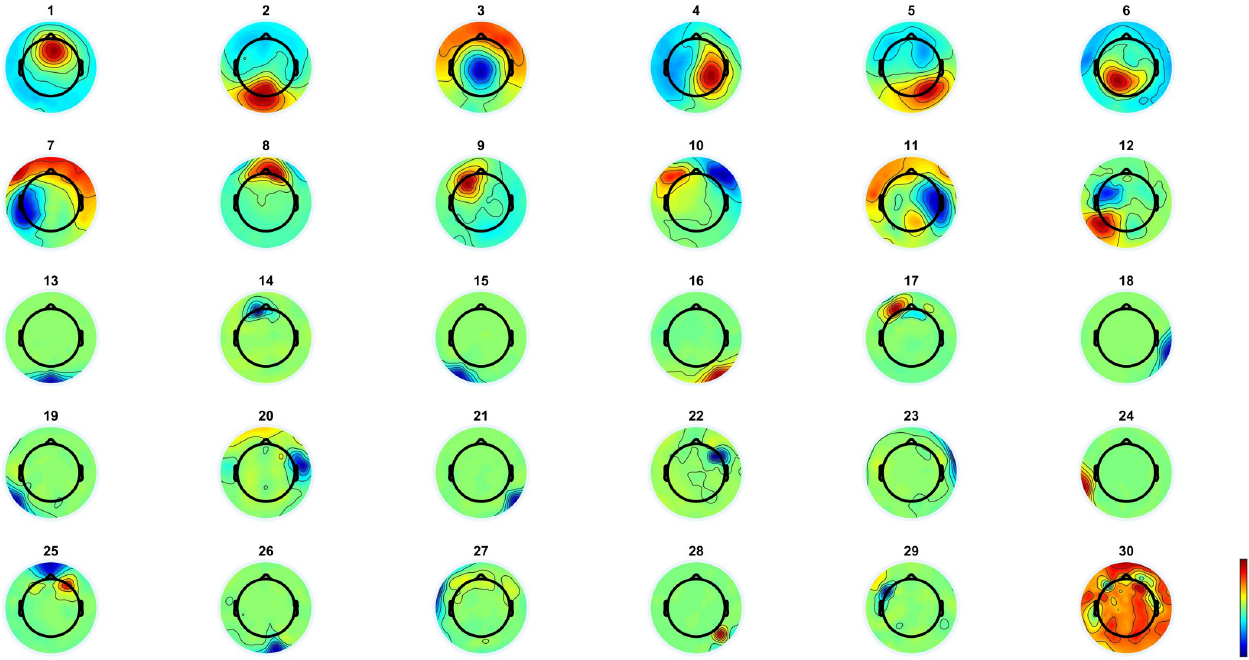
Fig 2. The group-level ICA estimated spatial filters. Components 1, 2, 3, 4, 5, 6, 7, 9, 11 and 12 were retained in the data because they were judged to have a dipolar field structure and thus were likely be generated by brain tissue. Components 8 and 10 were pruned out of the data since they were judged to be likely to have been caused by eye movements. Components 13, 14, 15, 16, 17, 18, 19, 20, 21, 22, 23, 24, 25, 26, 27, 28, 29 and 30 were pruned out of the data because they were judged to be random pop-out artefacts and mechanical artefacts mostly constrained to few channels.